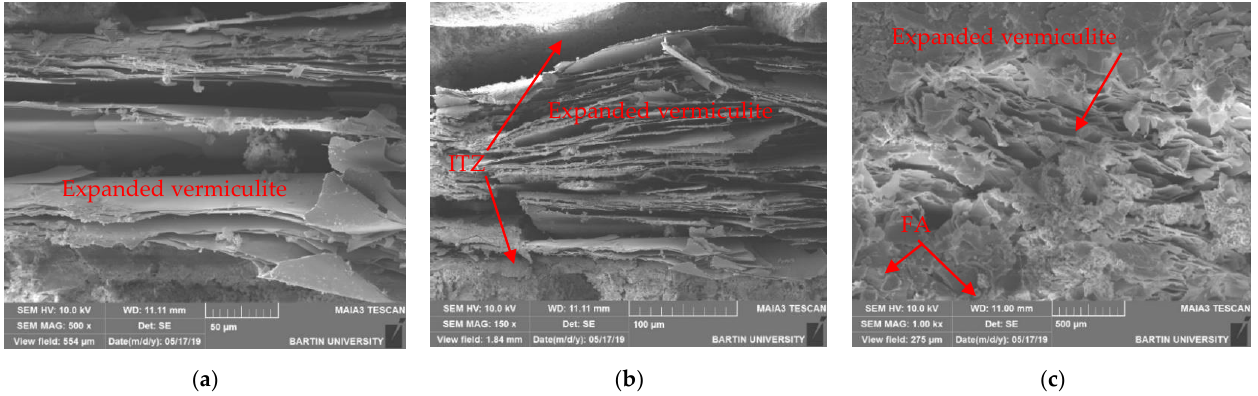
Figure 6. ( a – c ) SEM images of fresh-cut surfaces of the S20F50V30A specimen with different magnifications.